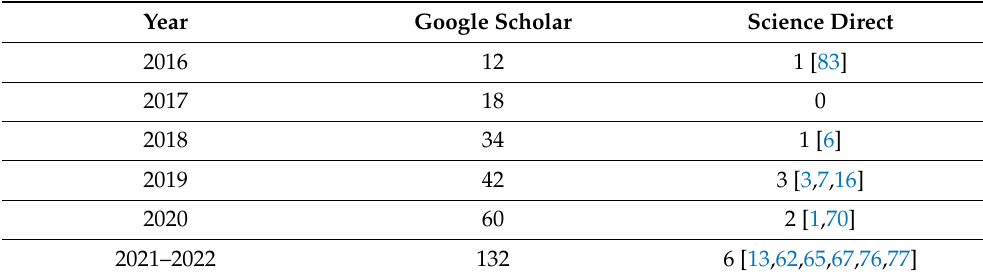
Table 2. Search and relevant result of keywords: “cattle” and “bolus” and “Artificial Intelligence” and “cattle” and “bolus” and “Machine